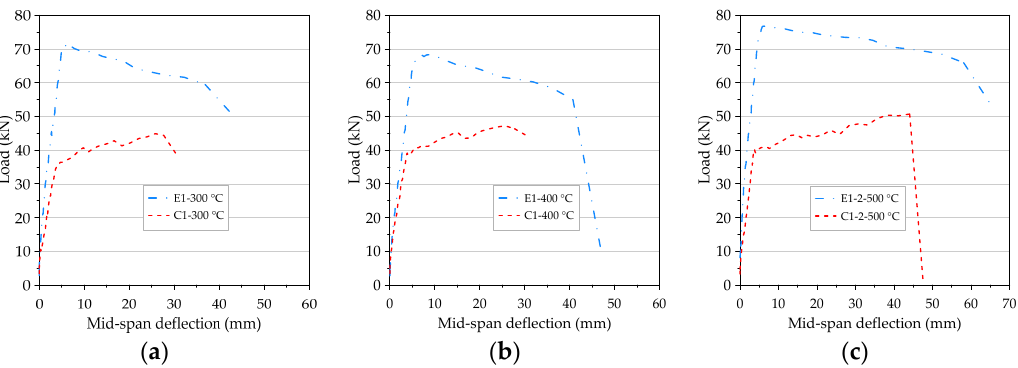
Figure 21. The comparison of load–deflection curves of two groups of beams after being subjected to high temperatures: ( a ) 300 °C, ( b ) 400 °C, and ( c ) 500 °C.